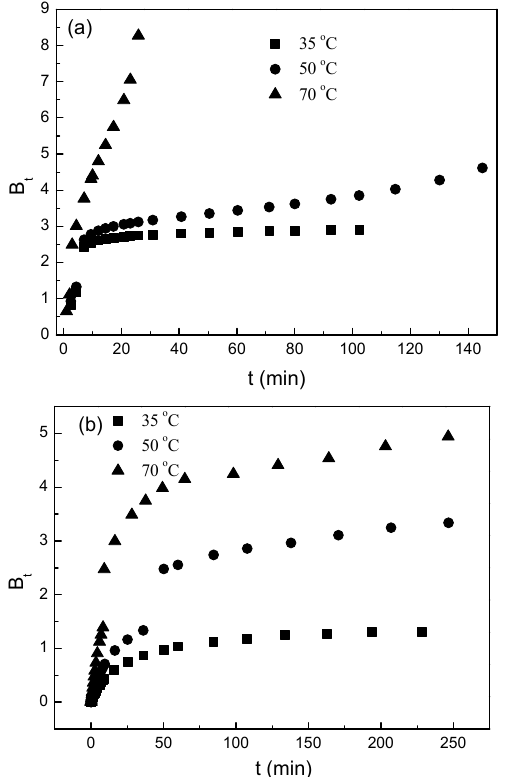
Figure 5. Boyd plots for CO 2 desorption from MCM-41 ( a ) and MCM-41-TEPA and ( b ) at 35, 50, and 70 °C.